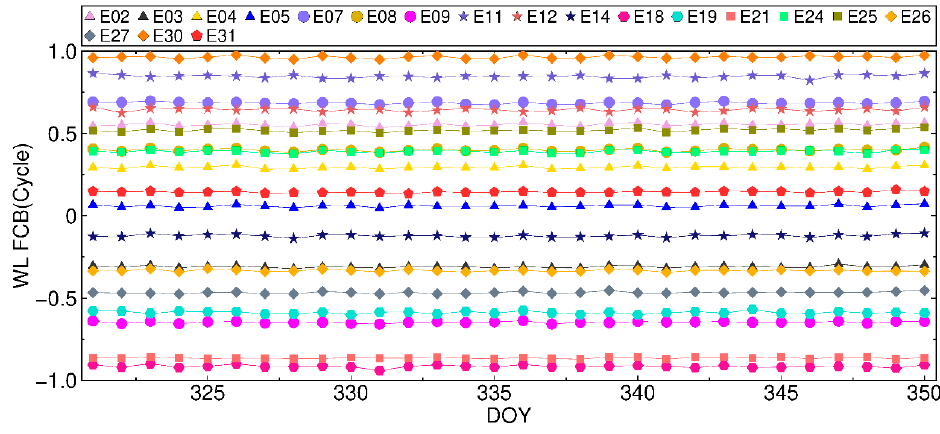
Figure 4. Galileo WL FCB from DOY 321 to 350, 2018, referenced to E01.